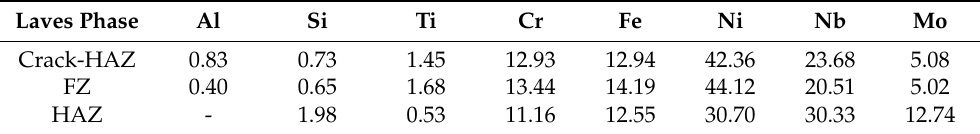
Table 8. Composition of Laves phases (in wt %) at different locations in 9 mm thickness sample of Mould P. Laves Phase Crack-HAZ